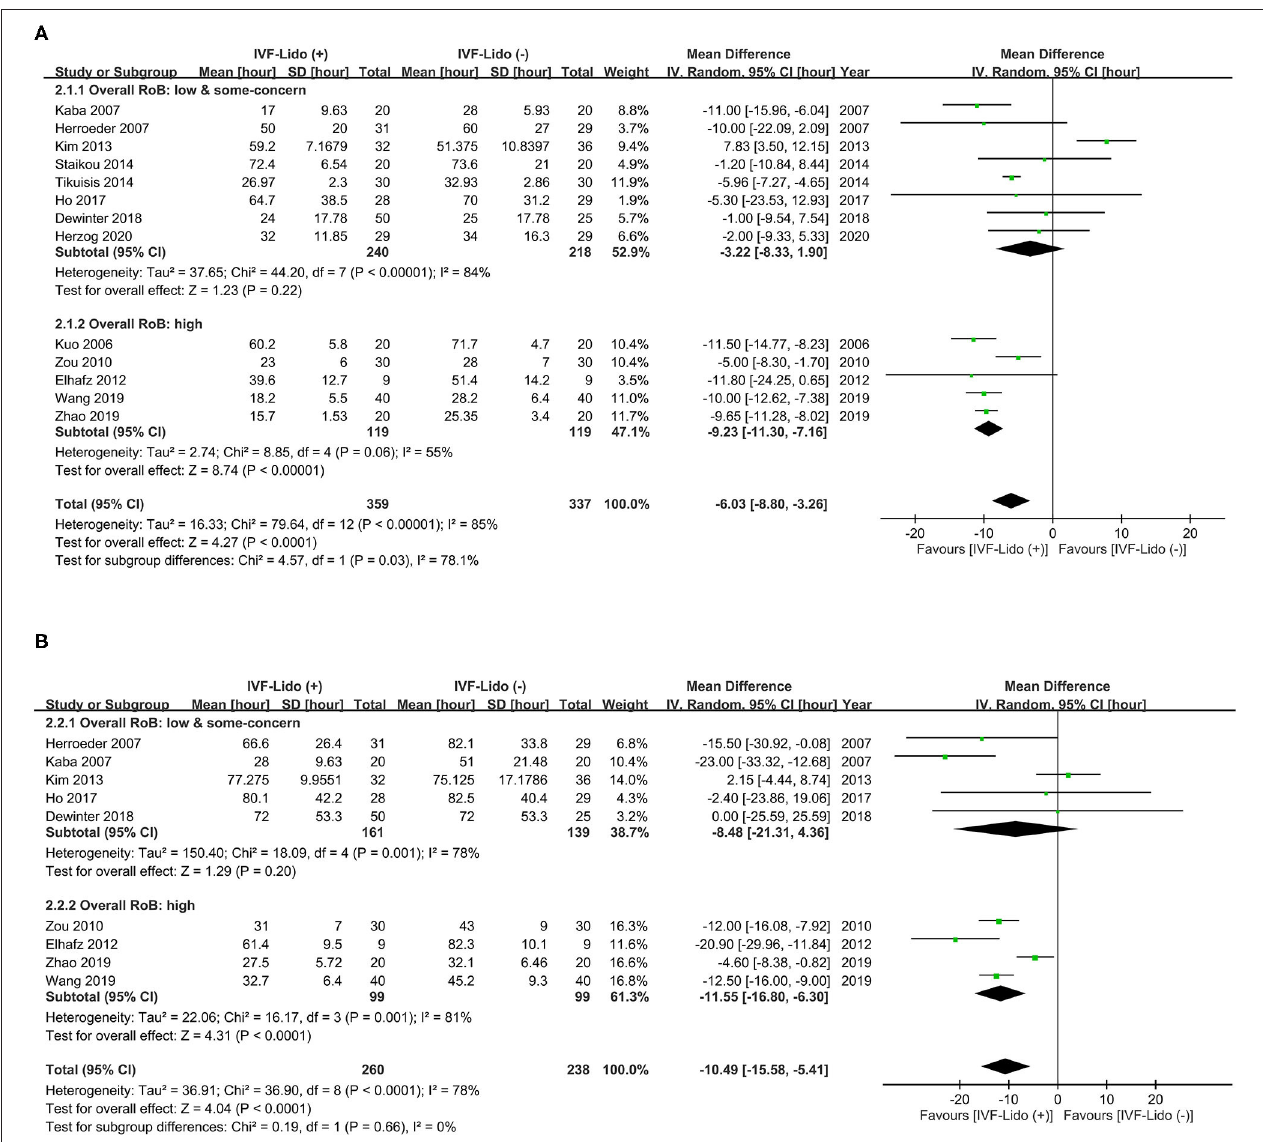
FIGURE 3 | Effect of intravenous infusion of lidocaine on the time (hours) to (A) first flatus and (B) defecation. A Forest plot with subgroup analysis is divided into two groups, namely, high and low/some-concerned overall RoB. IVF-Lido, intravenous infusion of lidocaine; RoB, risk of bias; SD, standard deviation; CI, confidence